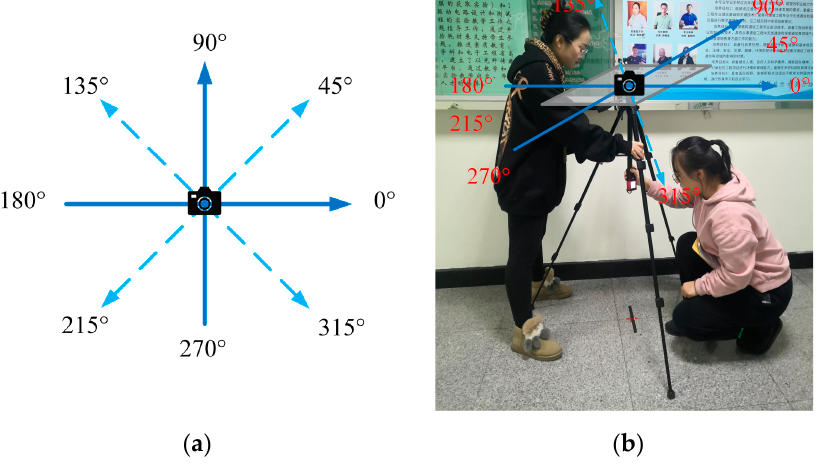
Figure 3. ( a ) Image capture angle; ( b ) determination of image acquisition position.